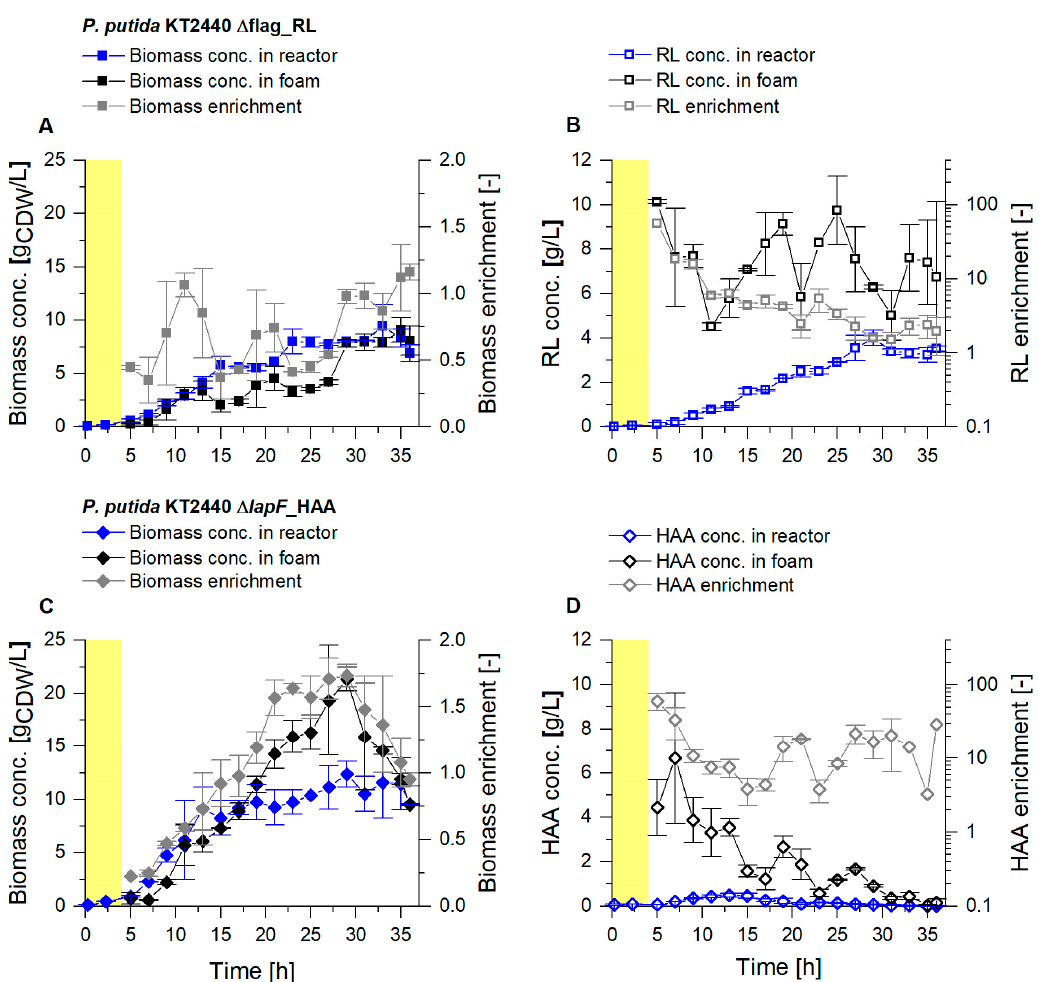
Figure 3. Cultivation of P. putida KT2440 Δ flag_RL ( A , B ) and P. putida KT2440 Δ lapF _HAA ( C , D ) in a bioreactor with 2 L working volume. Growth phase (yellow background) and a subsequent continuous product separation during the harvest phase (t = 4 h to t = 36 h). ( A , C ) Biomass concentration in the reactor (blue) and in the fractionated foam (black) and the biomass enrichment ( E X , gray). ( B , D ) Surfactant concentrations were measured in the fermentation broth of the reactor (blue) and in the fractionated foam (black), depicted together with the surfactant enrichment ( E P , gray). The error bars indicate the deviation from the mean of two biological replicates.